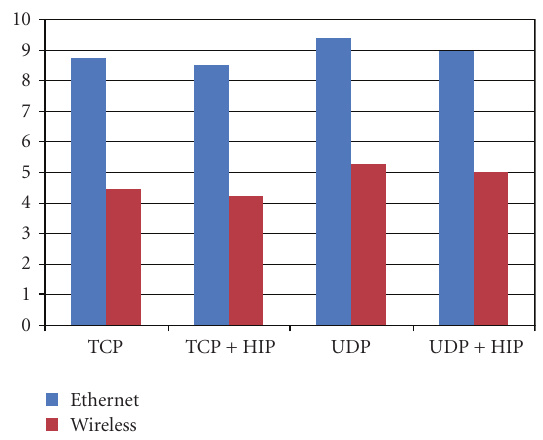
Figure 6: Test Scenario C results—Throughput (Mbits/s) for di ff erent